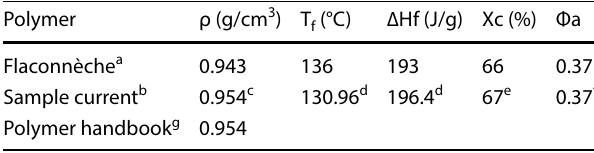
Table 1 Characteristics of the polymers before permeation tests